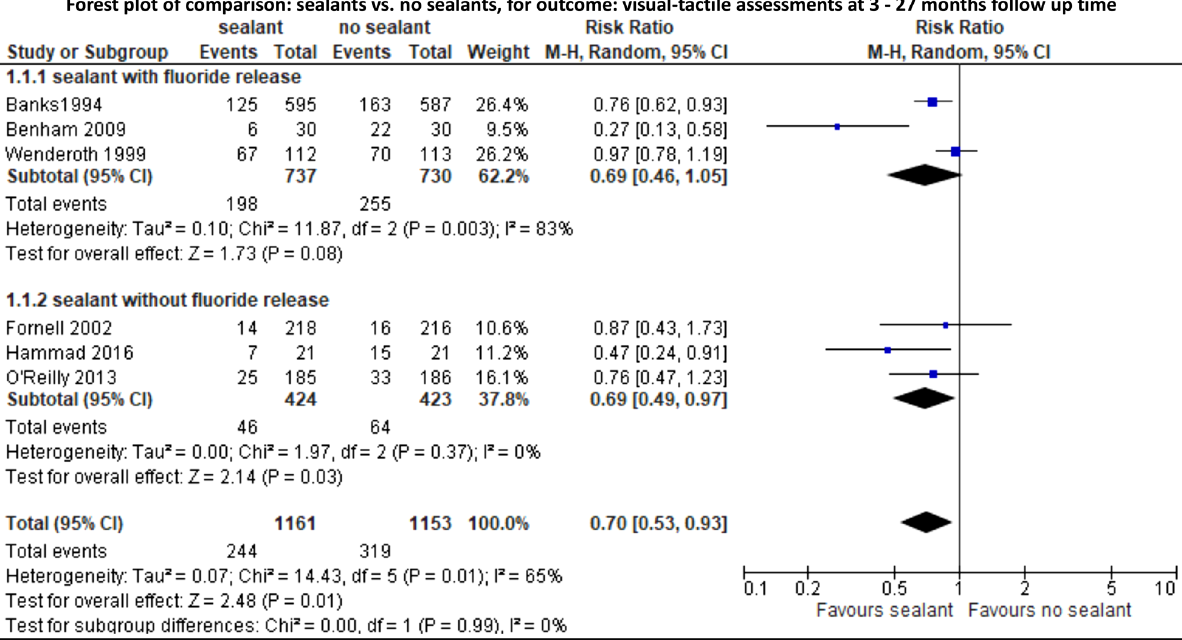
Figure 3. Meta-analysis for the comparison: sealant vs. no sealant. Visual-tactile assessments were used to calculate RR and